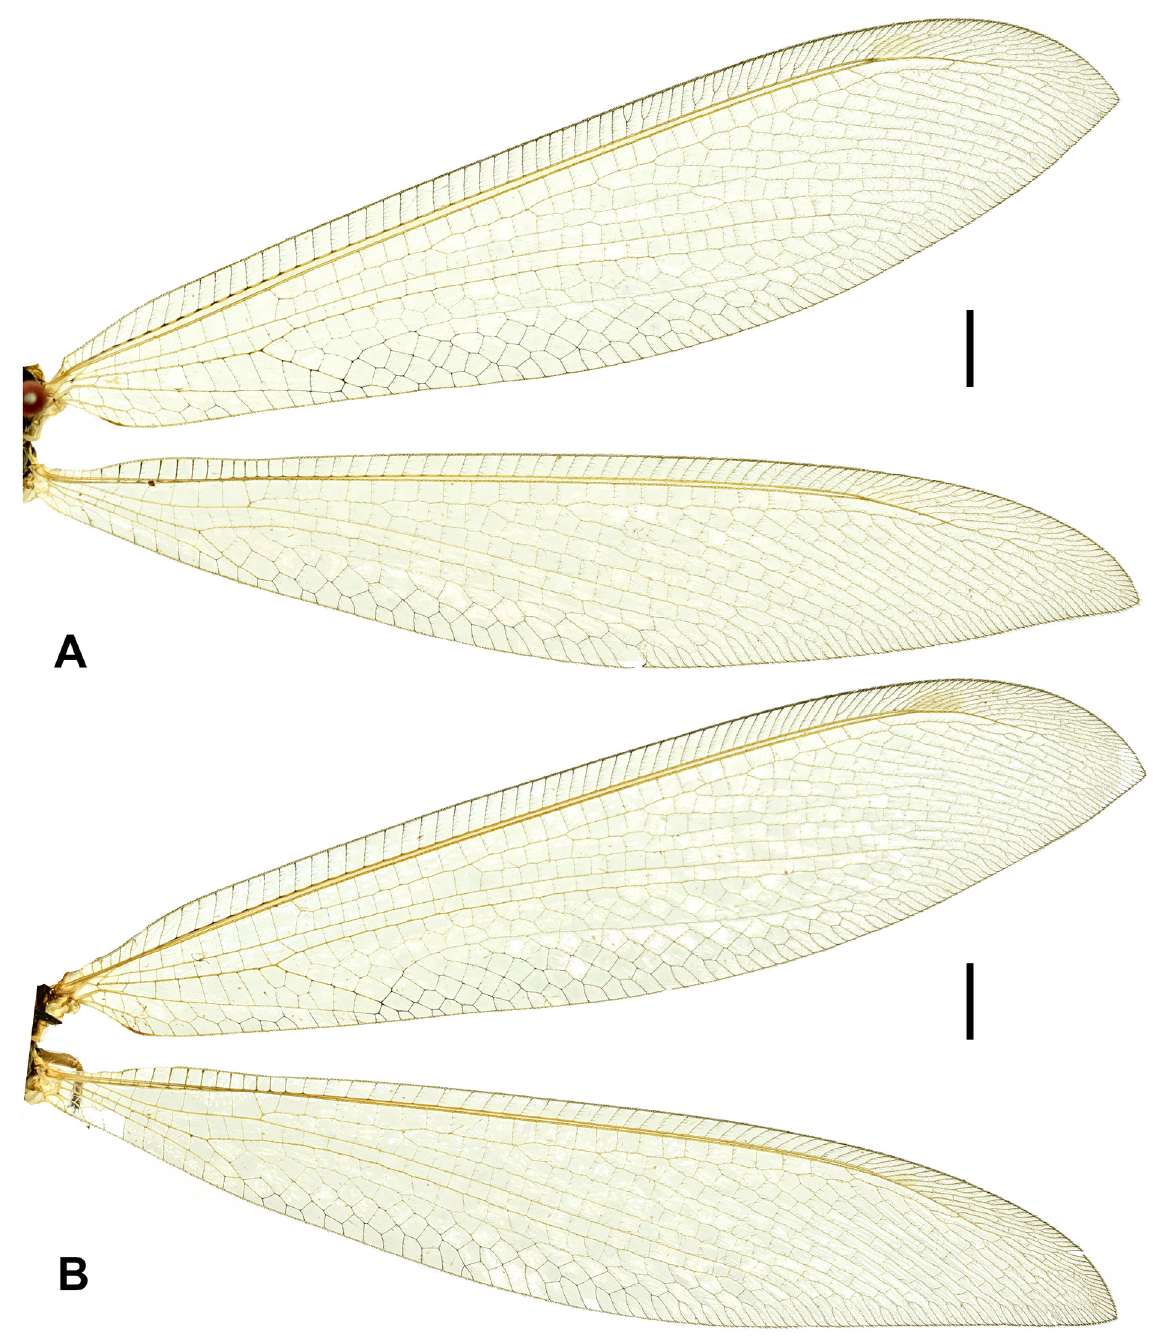
Fig. 17. Myrmeleon trivialis Gerstaecker, 1885. Right fore- and hind wing. A . Male (CAUPK000025). B . Female (CAUPK000026). Scale bars = 2.0